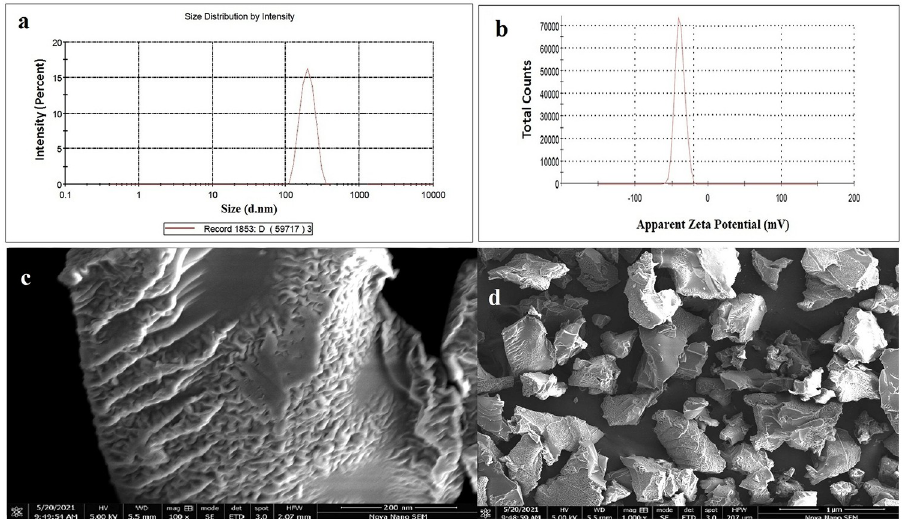
Fig 3. Particle size distribution curve showing low PDI (a) zeta potential curve indicating surface charge for better dispersion (b) and morphological characteristics (c, d) of β CD/PVP-co-poly (AMPS)